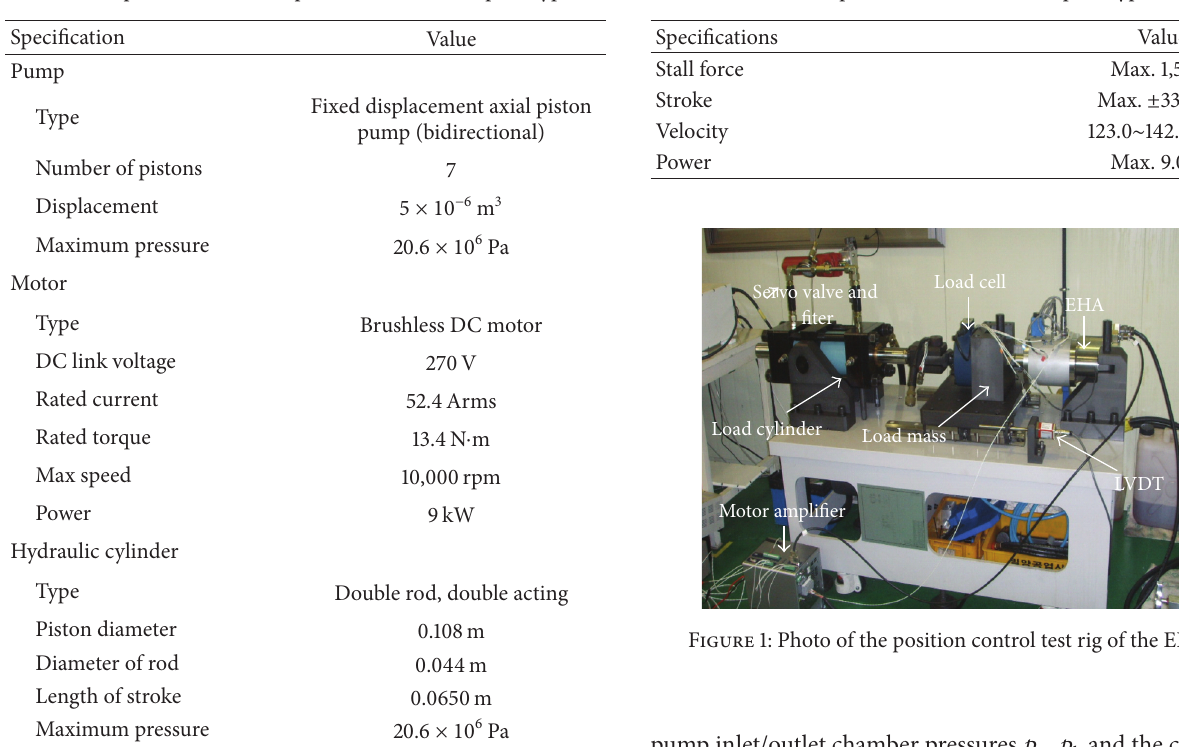
Table 1: Specification of components for the EHA prototype. Table 2: Specifications of the EHA prototype.